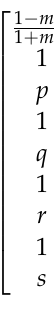
1 2 x for different values of m by ignoring other parameters.